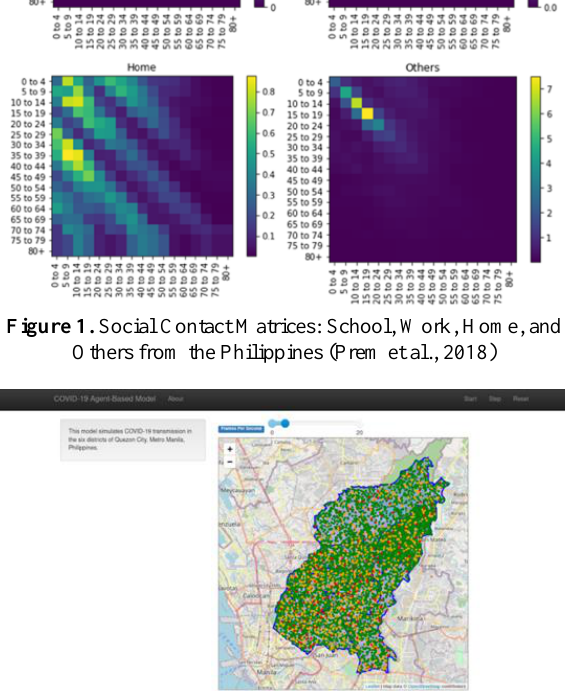
Figure 2. GIS Component of the COVID-19 Agent-Based Model . Green dots represent the susceptible, orange for exposed, red for infectious, and grey for removed (i.e., dead, recovered, and